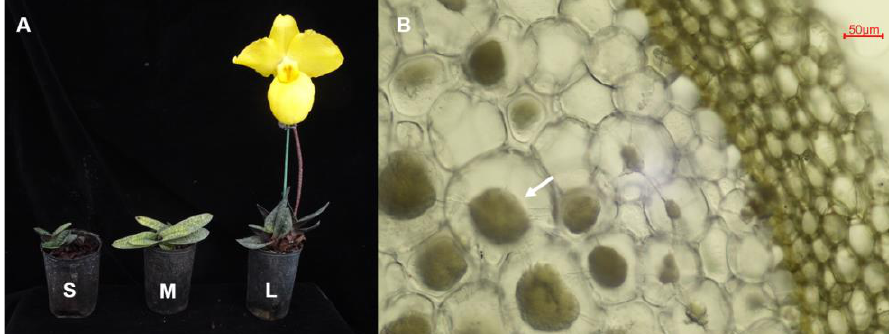
Figure 1. Different developmental stages of Paphiopedilum armeniacum ( A ) and freehand section of about 30 μm showing intracellular fungal pelotons in the roots ( B ). S: seedling stage; M: vegetative growth stage; L: reproductive growth stage. The white arrow indicates the intracellular fungal pelotons in the root.